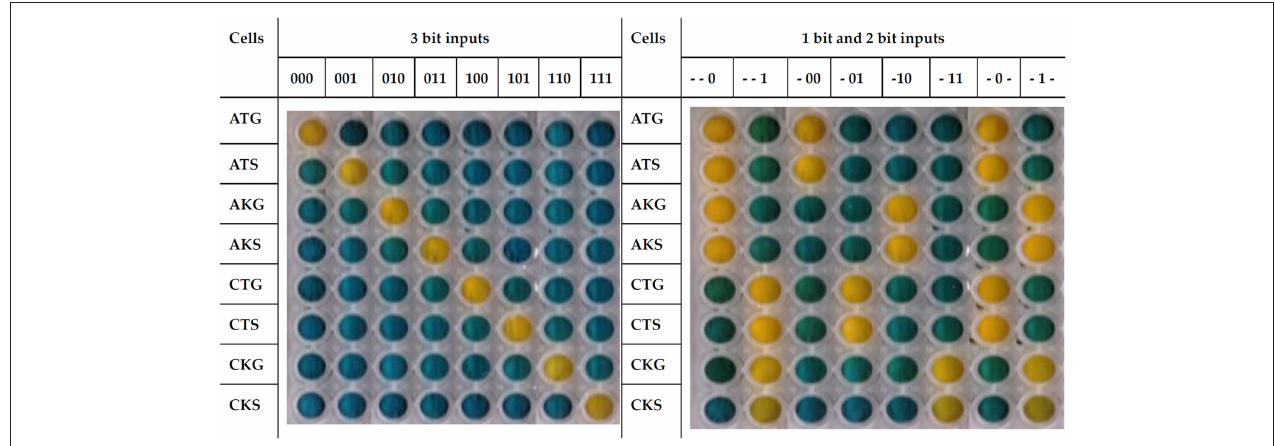
FIGURE 1 | ParAlleL responding to 1 bit, 2 bit, and 3 bit inputs. ParAlleL subcircuit cells were spatially distributed in different wells (vertically) and exposed to specified 1 bit, 2 bit, or 3 bit inputs (top of each column). Cells were inoculated (1:100) in LB supplemented with 1% w/v glucose. After 18h of incubation at 37 ◦ C, plates were developed by addition of 0.05 volumes of the developing